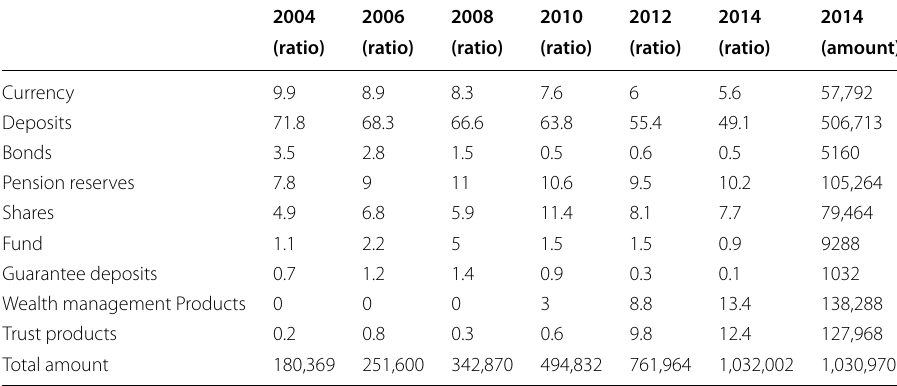
Source: Li et al. (2015) and Tang